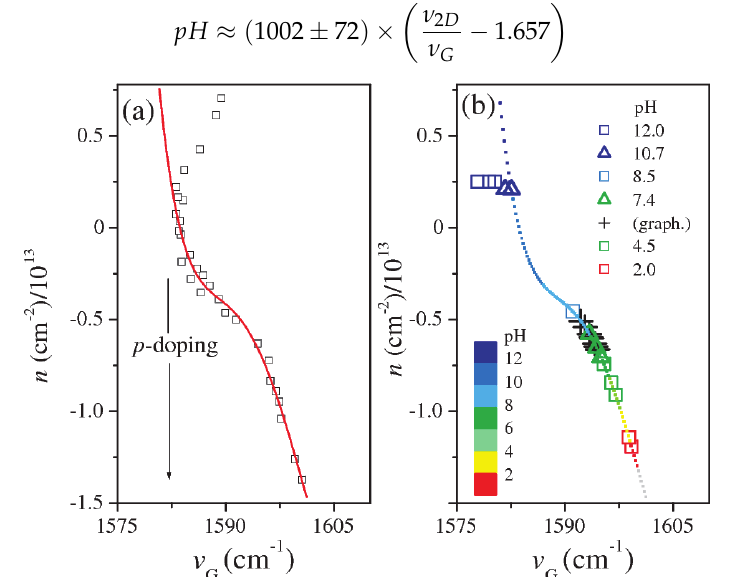
Figure 2. ( a ) An empirical analytical relation between n and ν G has been obtained by fitting the experimental data (squares) taken from [17]. ( b ) Estimations of the doping carrier density n for aqueous solutions at different nominal pH levels (pH = 2.0, 4.5, 7.4, 8.5, 10.7, 12.0). Black crosses refer to pristine graphene (with air contact). A pH scale is empirically assigned to the n dependence on ν G and graphically shown by the color mapping.